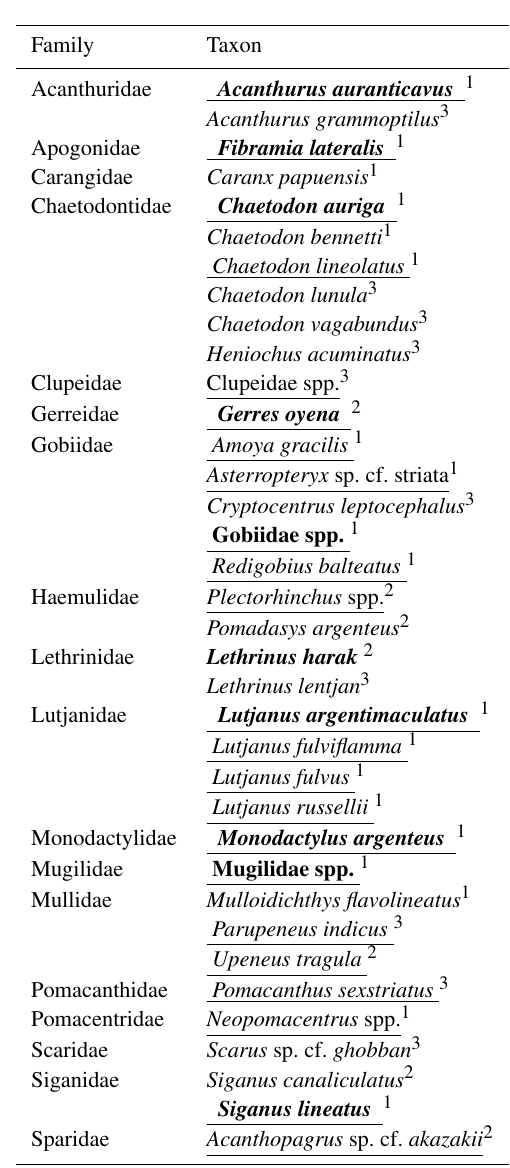
Table 2. The 36 common fish taxa identified by underwater video cameras at Bouraké, New Caledonia. The superscript number cor- responds to the type of patterns of mangrove utilisation across DO followed by the taxon (Fig. 6): Pattern 1 – “High tolerance”, Pat- tern 2 – “Medium tolerance” – and Pattern 3 – “Low tolerance”. Taxa highlighted in bold represent the 10 most common taxa. Taxa recorded in forest (5m inside the forest) are